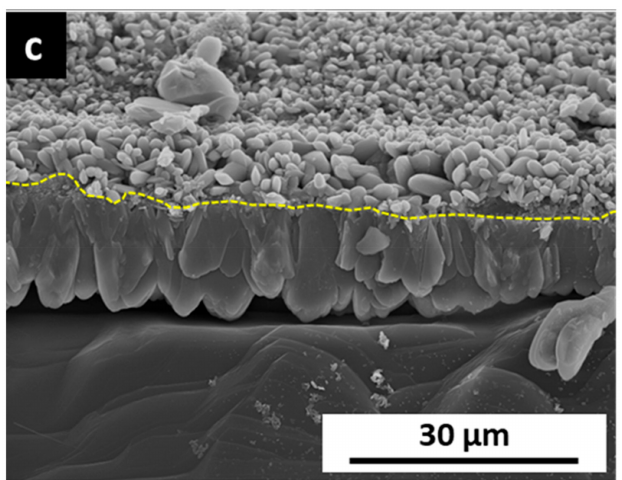
Figure 3. SEM micrographs showing the characteristics of the transformed celestite layer. ( a ) A shell-rim of celestite crystals encapsulates a gypsum crystal that has interacted 1 h with a 0.5 M Sr-bearing aqueous solution. ( b ) Cross cut section image that shows the sharp contact between the unreacted gypsum core and the celestite rim (Interaction time = 3 h). A progressive wider gap develops at the contact between the celestite layer and the gypsum core as the interaction time increases. ( c ) Cross-cut section image that depicts the two regions that can be distinguished within the celestite layer after an interaction time of 30 min. The most outer region is fine grained celestite while the most inner one consists of crystals arranged with their longest axis perpendicular to the retreating surface of the gypsum crystal, defining a stockade-like